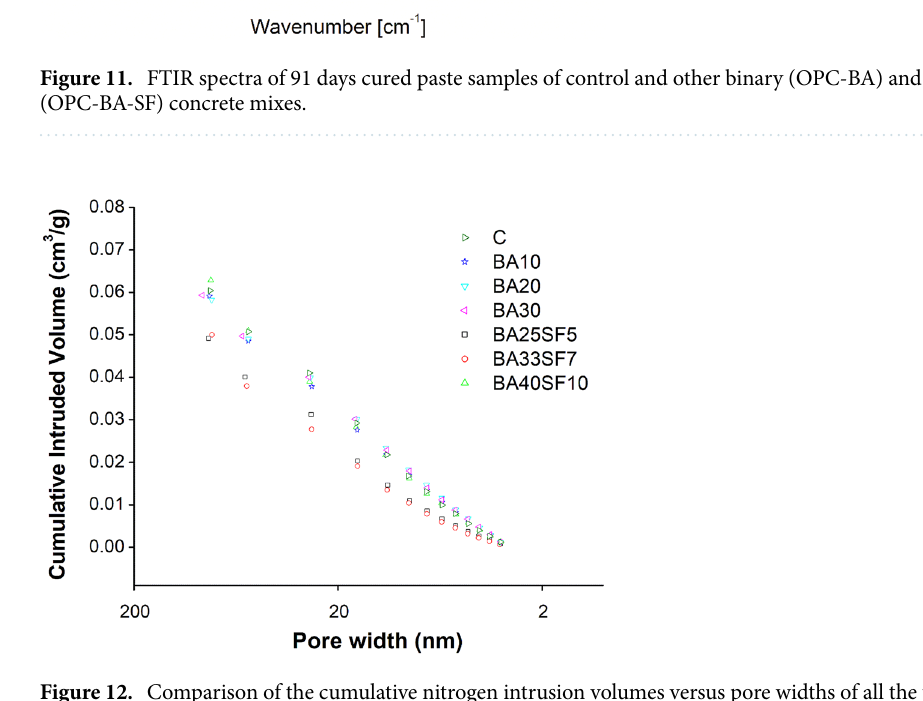
Figure 12. Comparison of the cumulative nitrogen intrusion volumes versus pore widths of all the tested paste samples (control, binary and ternary) subjected to 91 days of standard